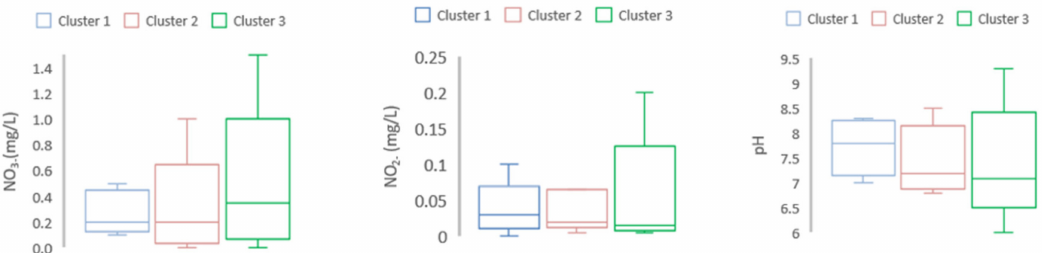
Figure 6. Water quality variables among three Clusters in the dry season. NO 3 − , NO 2 − , and pH were found higher in Cluster 3 than those in Clusters 1 and 2.